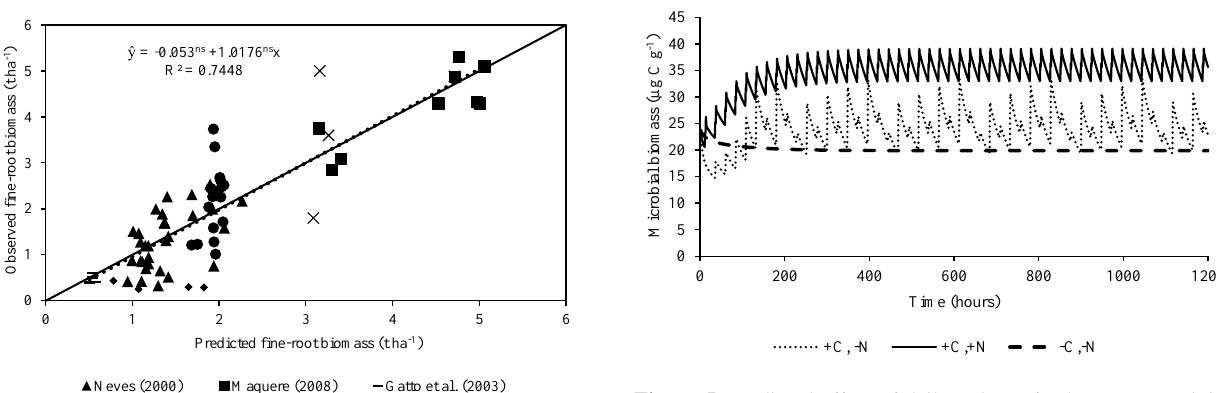
Figure 5. Predicted effect of daily pulses of substrates containing water, water + C, or water + C + N (as occurred in Drake et al., 2013) on microbial biomass during 50 days of treatment.